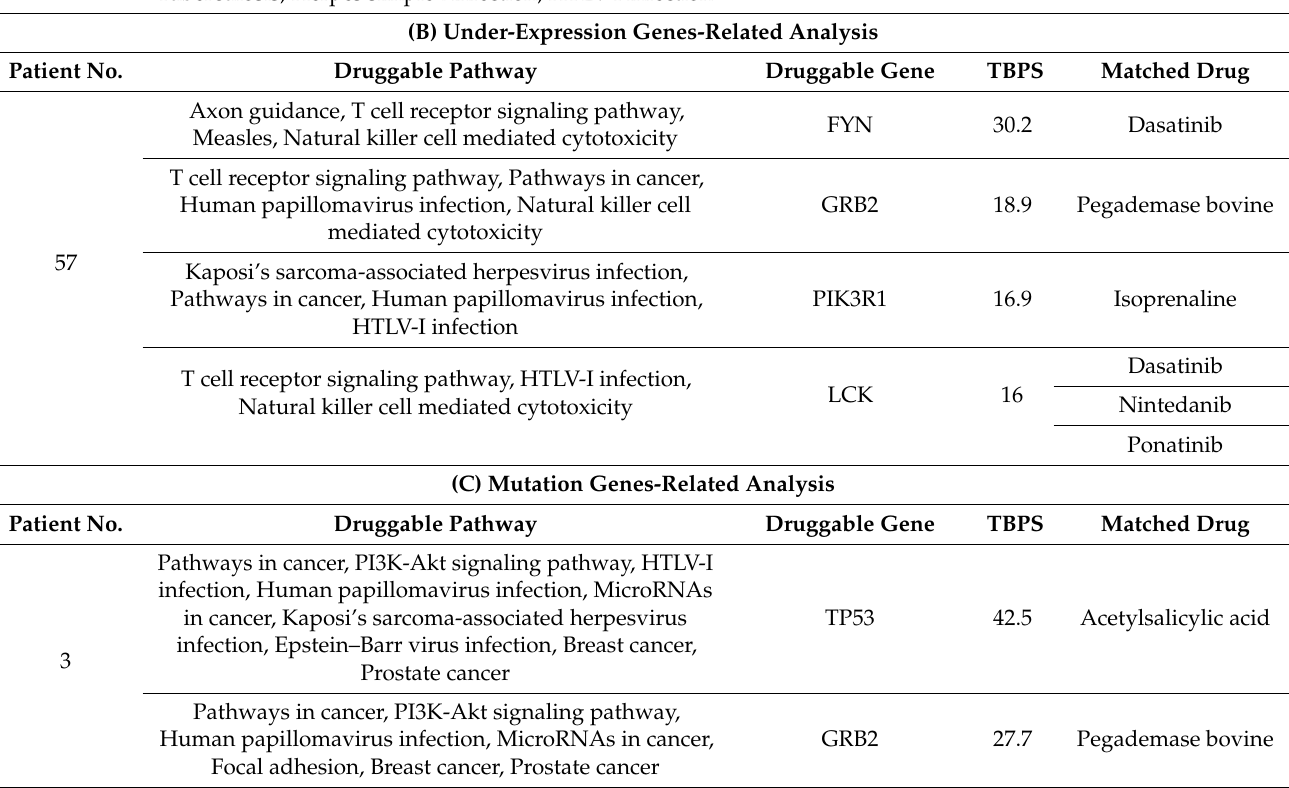
CD274: Programmed cell death 1 ligand 1, CD3E: T-cell surface glycoprotein CD3 epsilon chain, CD80: T-lymphocyte activation antigen CD80, FYN: FYN Proto-Oncogene, FYN: FYN Proto-Oncogene, GRB2: Growth Factor Receptor Bound Protein 2, GRB2: Growth Factor Re- ceptor Bound Protein 2, JAK1: Tyrosine-protein kinase JAK1, LCK: LCK Proto-Oncogene, Src Family Tyrosine Kinase, PDCD1: Programmed cell death protein 1, PIK3R1: Phosphoinositide-3-Kinase Regulatory Subunit 1, TNF: Tumor necrosis factor, TP53: Tumor Protein